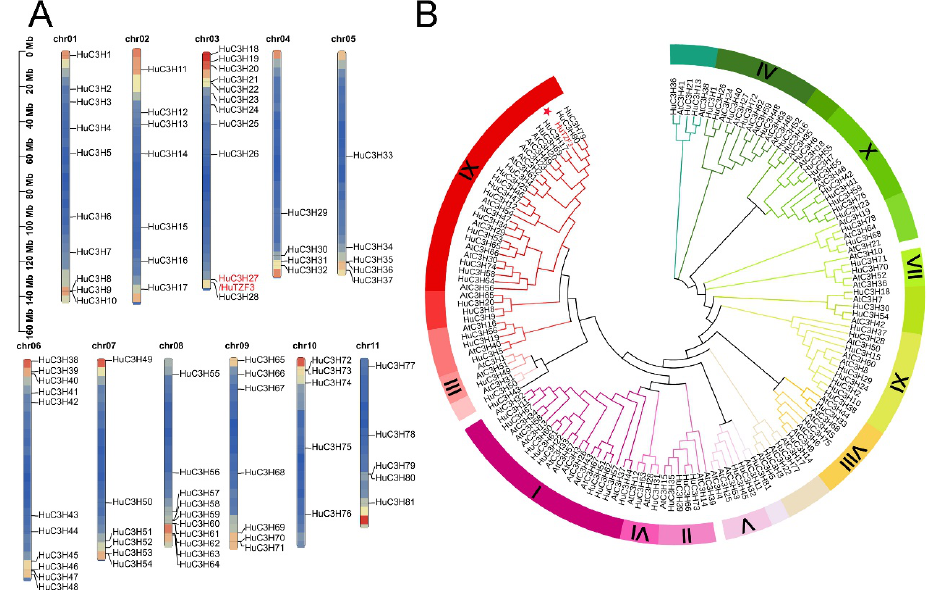
Figure 1. Systematic identification of the CCCH - type zinc finger protein genes from pitaya. ( A ) Chromosomal locations of pitaya CCCH genes. The chromosomal locations of HuCCCH genes were mapped by TBtools [ 32 ]. Names of the HuCCCH genes are shown on the right of the chromosomes. The scale of the genome size is shown on the left. ( B ) Phylogenetic tree of the CCCH proteins from pitaya and Arabidopsis . The 81 HuCCCH proteins from pitaya and the 68 AtCCCH proteins from Arabidopsis were used to construct the phylogenetic tree by MAG11 and visualized by iTOL. The red star indicates HuTZF3.